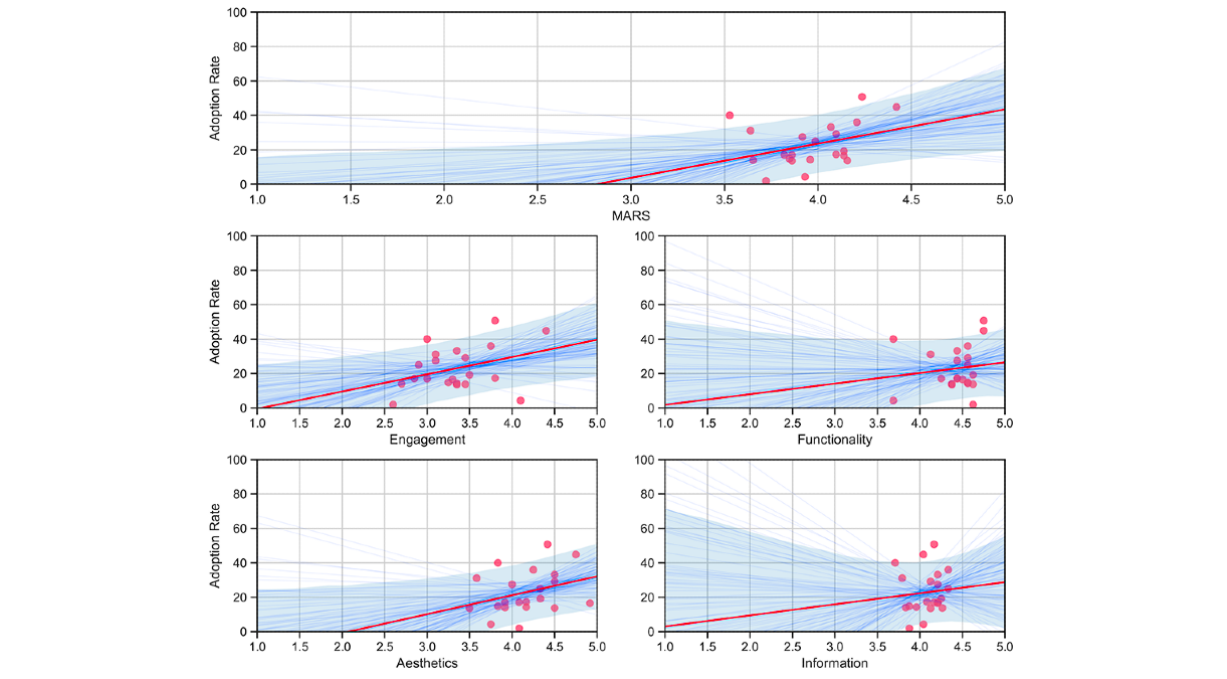
Figure 2. Bayesian regression with trend lines and 80% CIs (blue shaded area) for app characteristics and adoption of COVID-19 contact tracing apps. MARS: Mobile App Rating